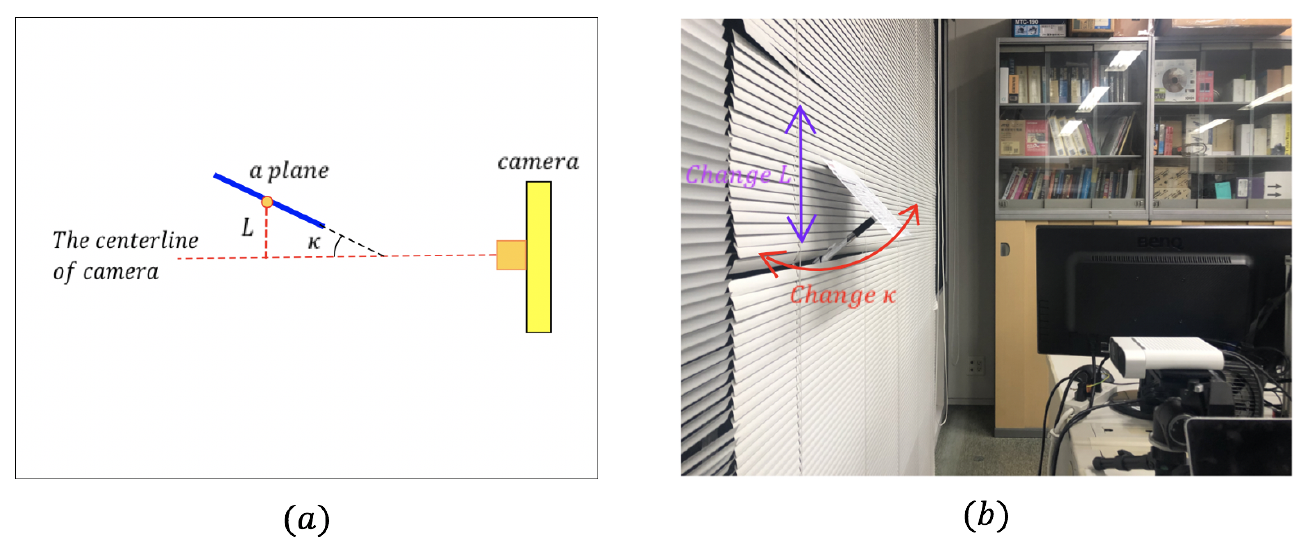
Figure 20. Distance and angle to object: ( a ) Schematic diagram. ( b ) Configuration change of the κ and L